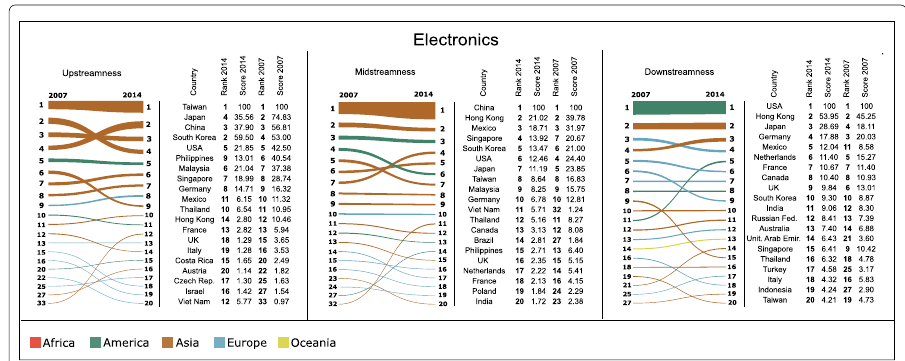
Fig. 2 Bump charts showing the variation in rankings and values of upstreamness ( left-handcolumn ), midstreamness ( centrecolumn ), and downstreamness ( right-handcolumn ) centralities of countries in the Electronics industry between 2007 and 2014. Each line in the bump charts shows the variation of ranking for each country, and the width of each line at the two endpoints is proportional to the centrality score in the corresponding year. Only the 20 top-ranked countries in 2014 have been included. The scores underlying the two rankings in each bump chart have been normalised so as to produce equal sums of widths of endpoints at each year. Beside each bump chart is a table illustrating the rankings and centrality scores normalised according to Eqs. 5, 7, and 9. The colour of each line in the bump charts refers to the geographic continent of the corresponding country. Bump charts were obtained using RAWGraphs